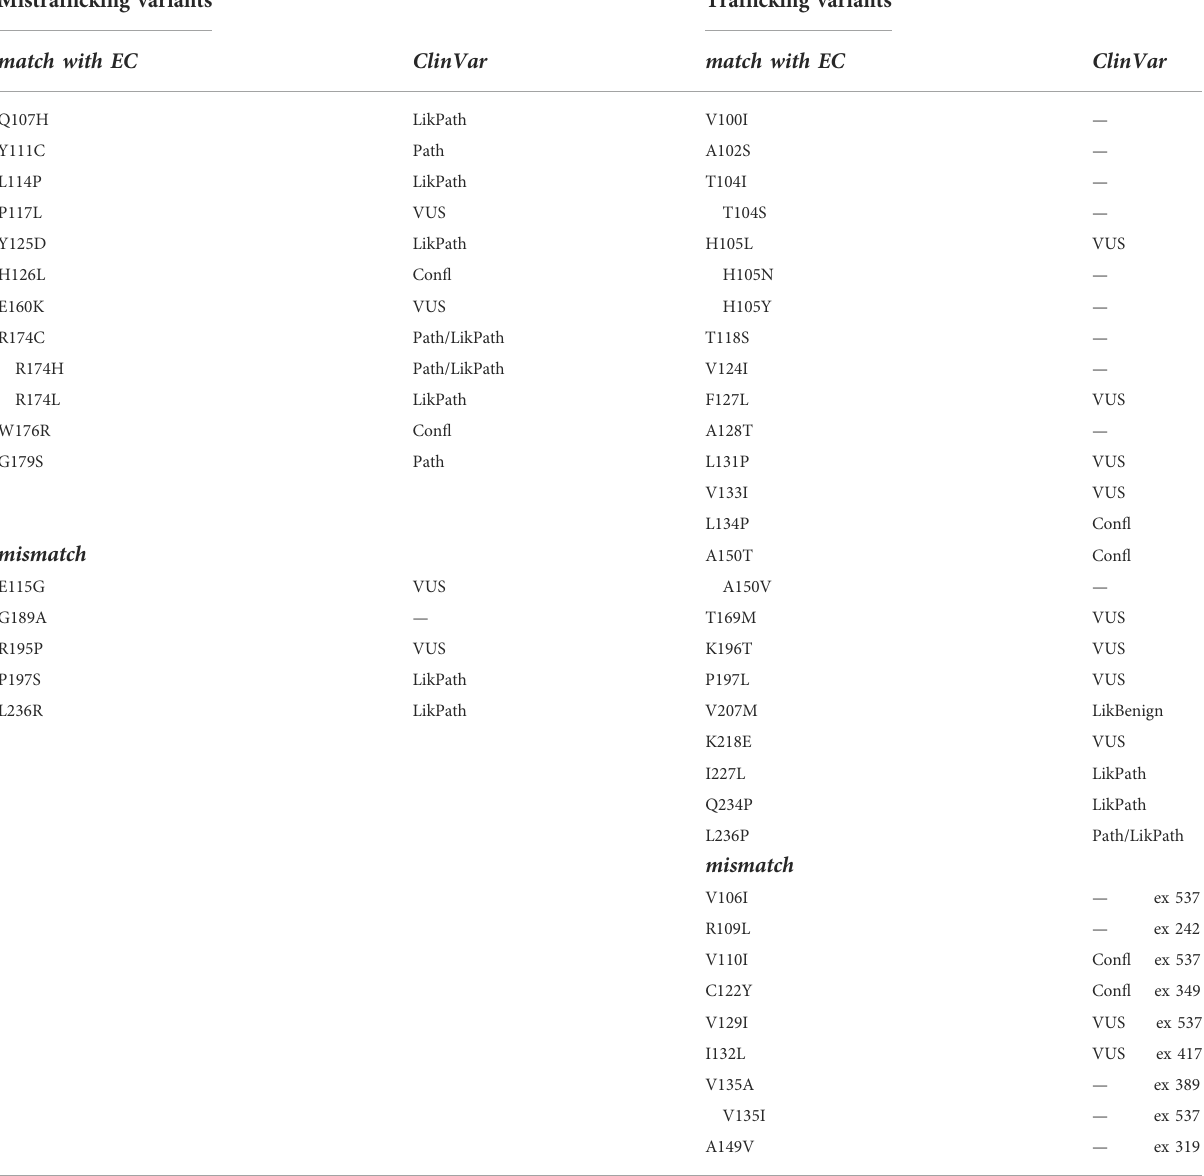
TABLE 1 Comparison of EC data with experimental traf fi cking data from Huang et al. (2018). Mistraf fi cking